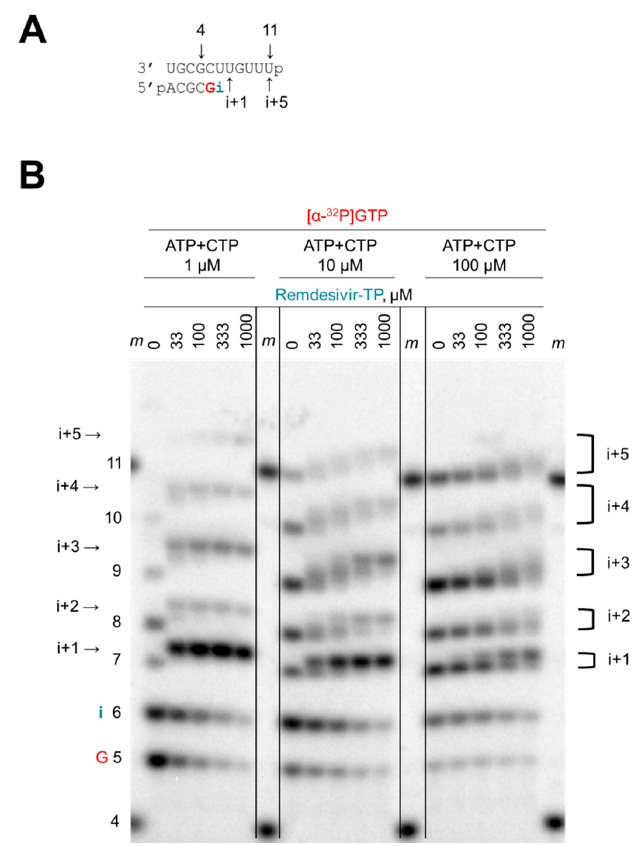
Figure 2. Competition between ATP and remdesivir-TP. ( A ) RNA substrate used in the reaction. Template and primer were both phosphorylated (p) at their 5 ′ -ends. G indicates incorporation of the radiolabeled nucleotide opposite template position 5. Position i allows incorporation of AMP or remdesivir-MP. ( B ) RNA synthesis was monitored with purified Ebola virus (EBOV) RdRp in the presence of [ α - 32 P]GTP, three different concentrations of the competing ATP+CTP (1 µ M, 10 µ M, 100 µ M), and increasing concentrations of remdesivir-TP (0–1000 µ M). The brackets indicate heterogeneous products containing either AMP or remdesivir-MP, or more complex mixtures due to multiple incorporation sites. Length markers ( m ) represent primer 4 and template